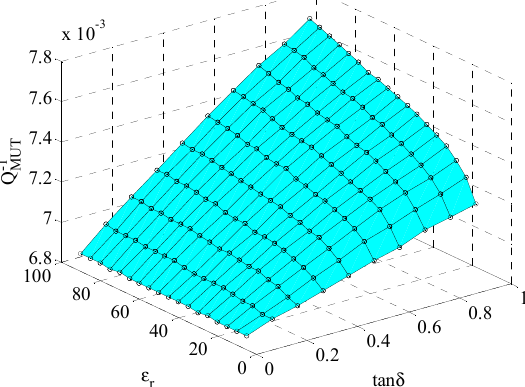
Figure 11. Nonlinear surface fitting for loss tangent and quality factor.